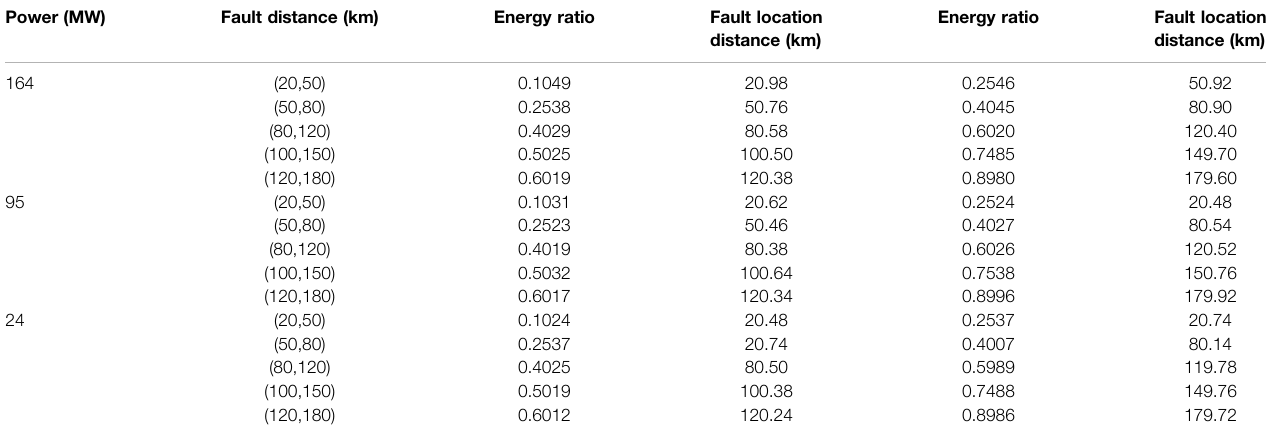
TABLE 4 | Abnormal ranging at different bipolar positions. Power (MW) Fault distance